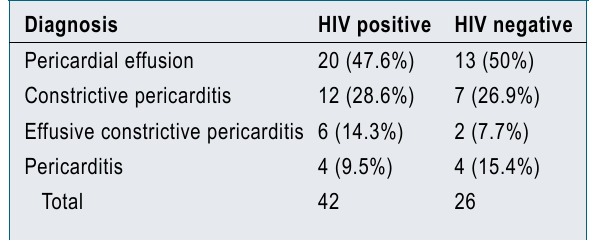
TABLE I. DIAGNOSES IN 68 PATIENTS WITH PERICARDIAL